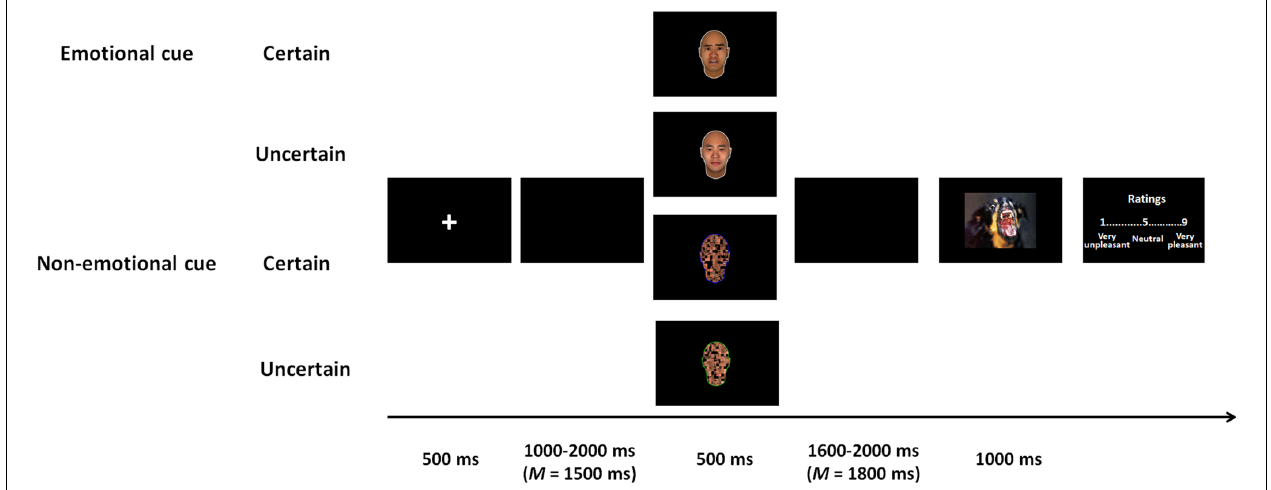
FIGURE 1 | Experimental procedure. Negative pictures were presented after certain or uncertain cues in either the emotional cue condition or the non-emotional cue condition.